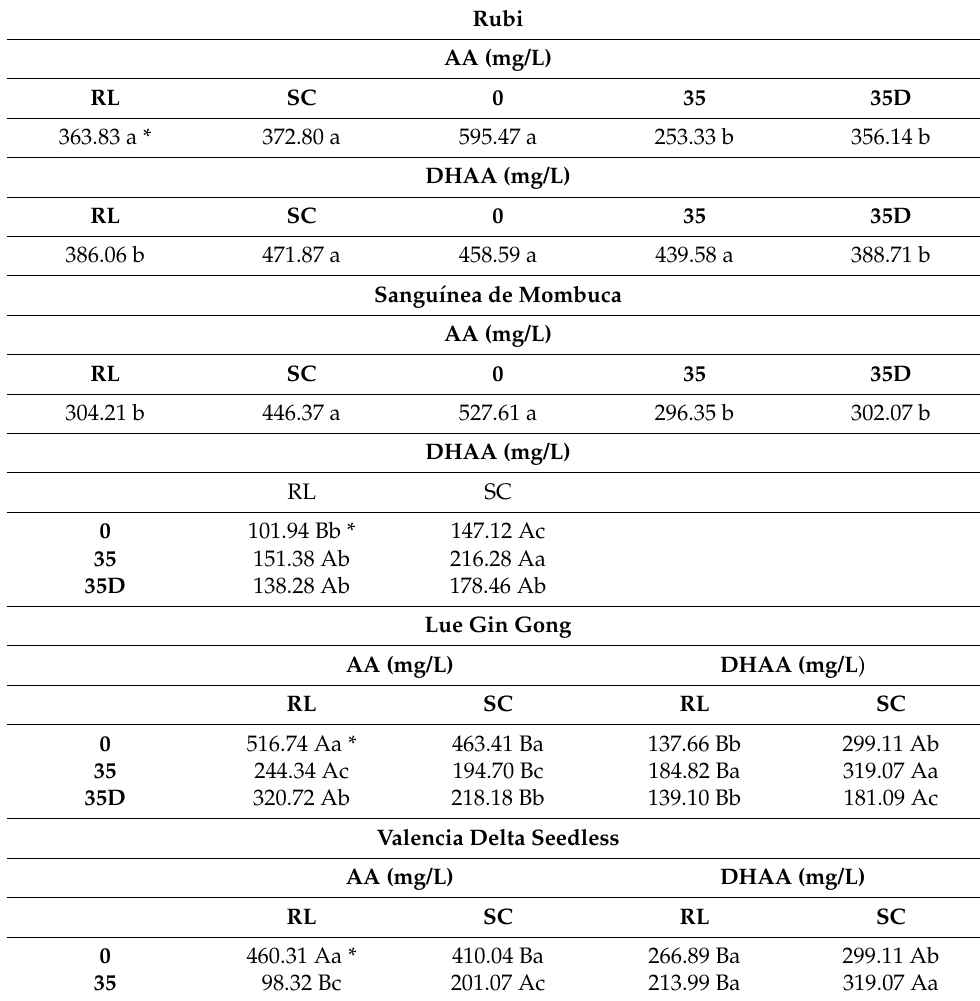
Table 2. Ascorbic acid and dehydroascorbic acid concentrations in juices from Rubi, Sangu í nea de Mombuca, Lue Gin Gong, and Valencia Delta Seedless cultivars with different rootstock combinations submitted to 35 days of